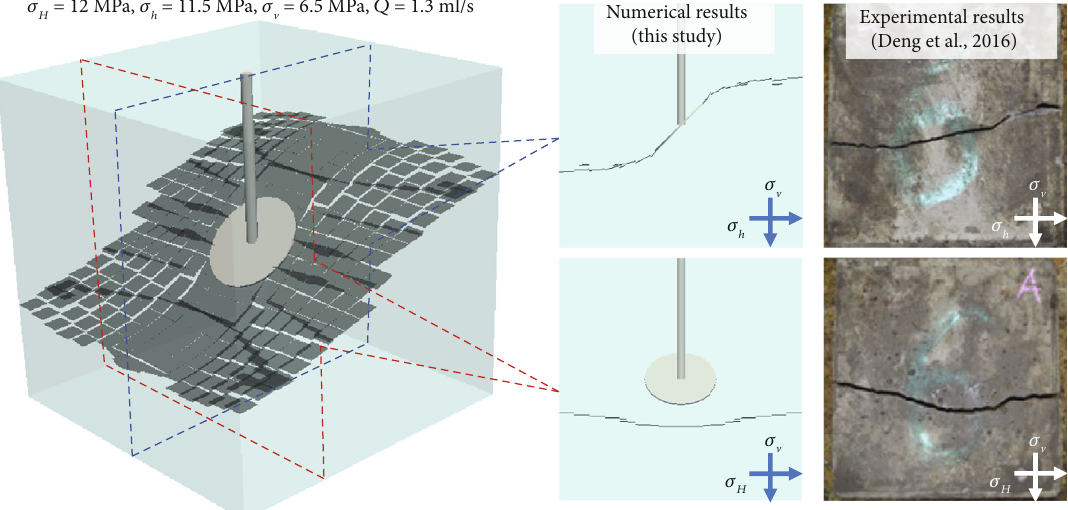
Figure 5: Spatial fracture pattern and comparison with experimental results in the simulation of lab-scale hydraulic fracture propagation with a preset slot.